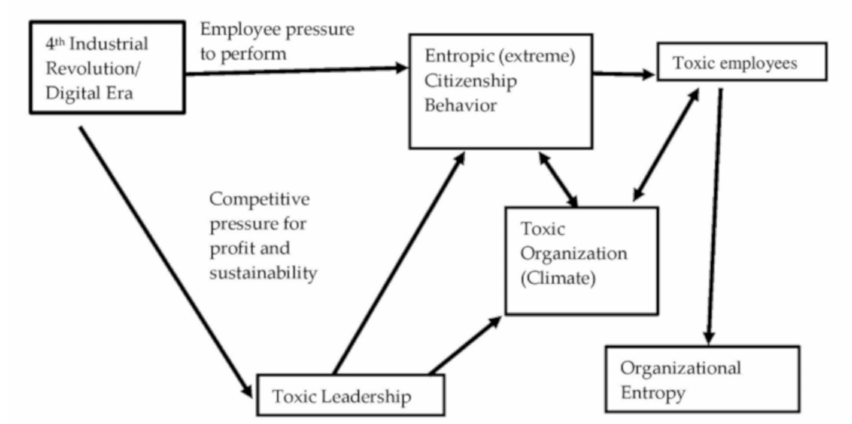
Figure 1. A theoretical model of negative influences of the fourth industrial revolution on workplace citizenship